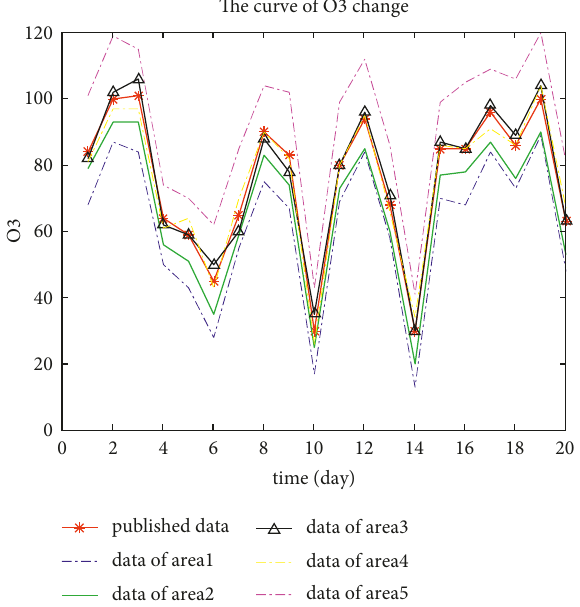
Figure 10: Curve of O 3 change in different task grid